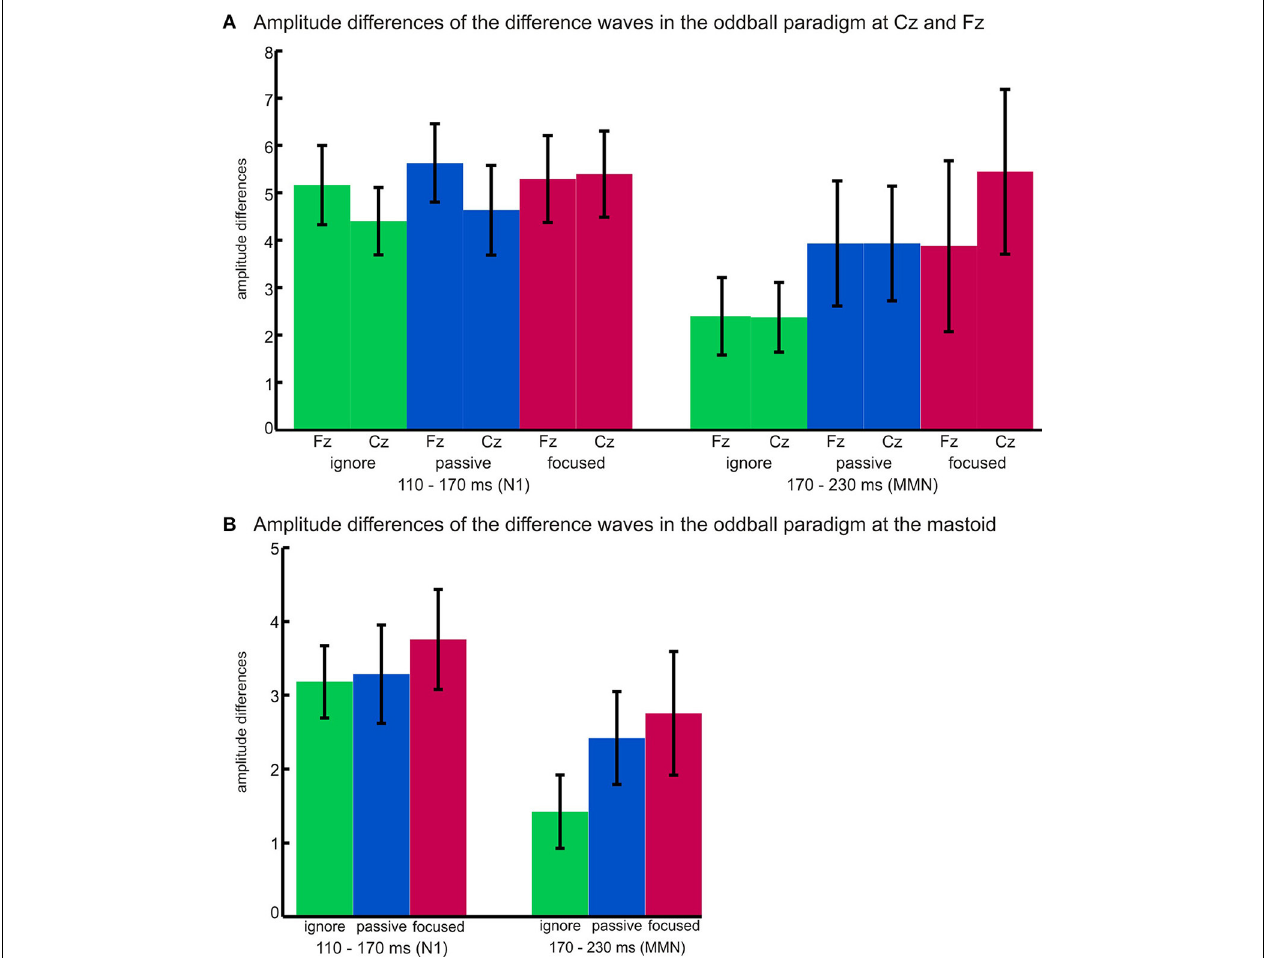
FIGURE 2 | MMN amplitude differences at (A) Fz and Cz and (B) the right mastoid for each task (ignore, passive, focused) in the two time windows (110–170ms and 170–230ms). Error bars represent standard deviations.